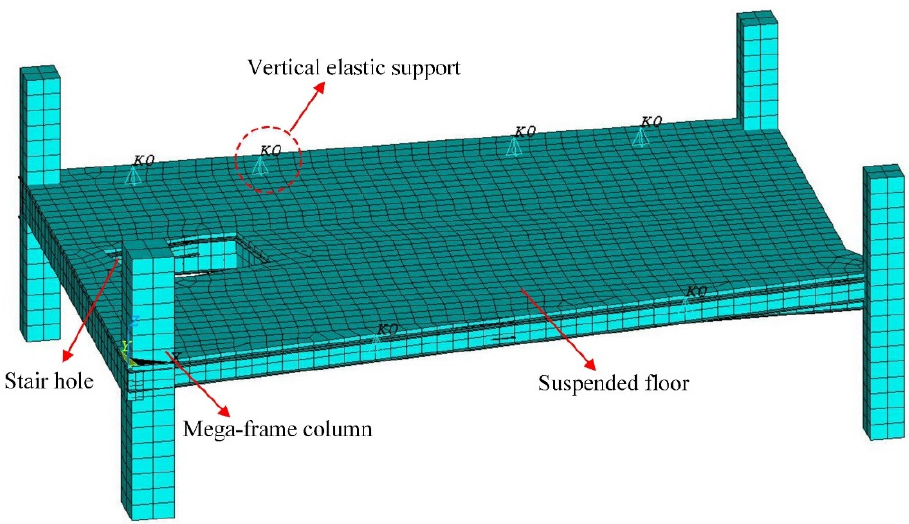
Figure 9. The local equivalent FE model of the suspended floor.